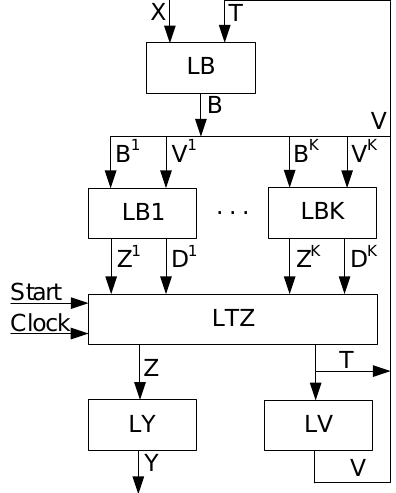
Figure 3. Structural diagram of MP T Y Mealy